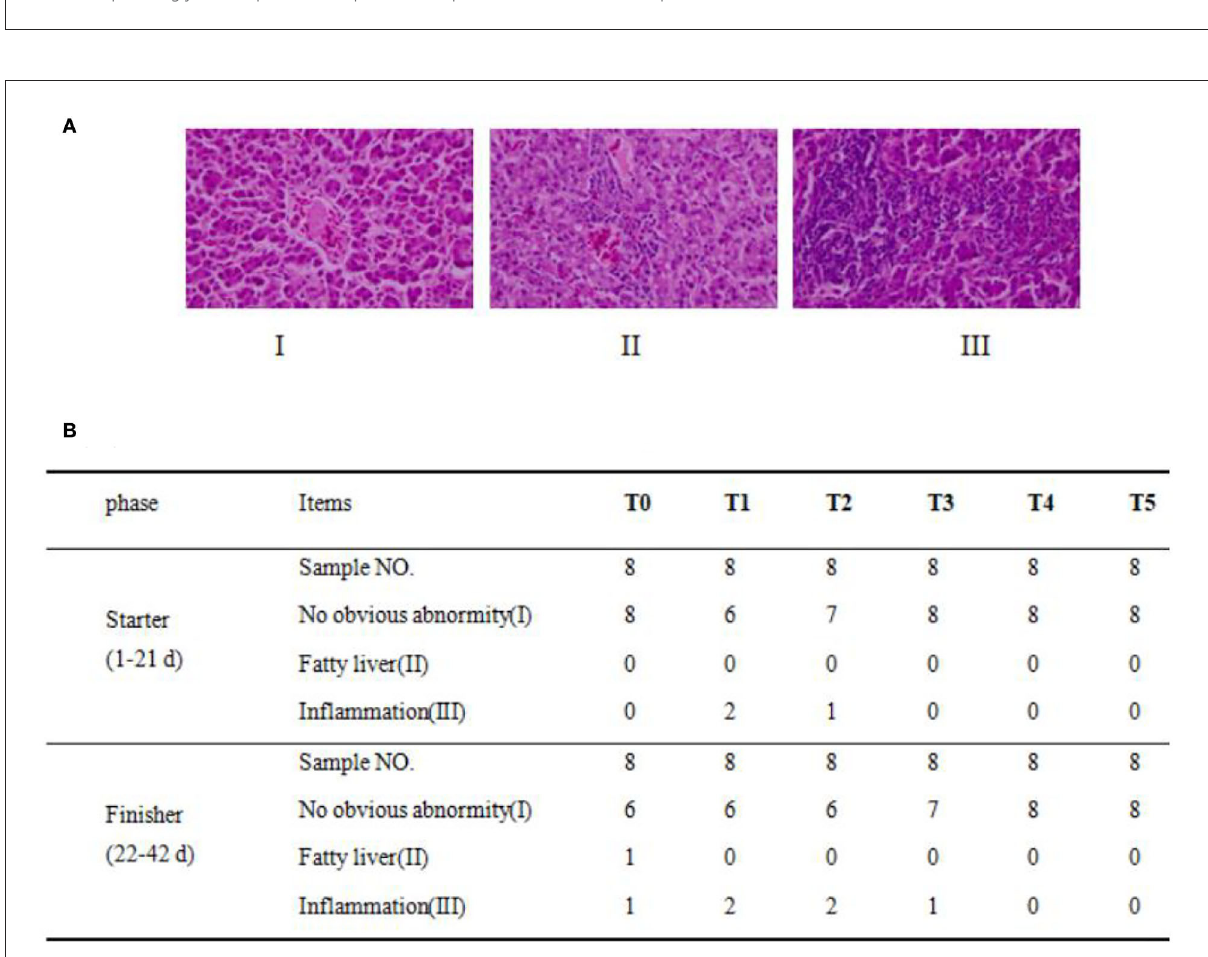
FIGURE2 Lipid metabolism in the liver of broiler when CAP partially replaced dietary SBM at the end (values having different letters are significantly different, P < 0.05, mean activated receptor). Receptor. Ed assynthase; ACC 1, acetyl-CoA carboxylase 1; CPT-1, Carnitine palmitoyltransferase; ATGL, adipose triglyceride lipase; PPAR, peroxisome proliferator-activated receptor.